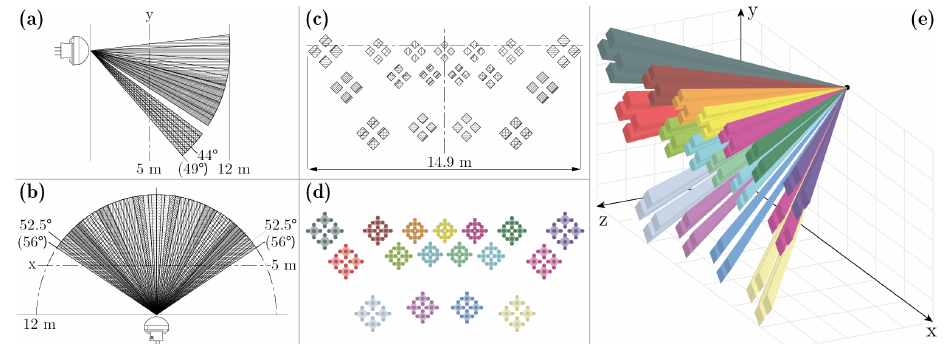
Figure 1. ( a ) side view of the Panasonic EKMC1604111 sensor’s field of view; ( b ) top view of the sensor’s field of view; ( c ) x–y cross-section of the sensor’s beam pattern; ( d ) beam pattern of the synthetic version of the EKMC1604111 sensor; ( e ) perspective view of the synthetic sensor’s beam pattern in 3D space. Subplots ( a – c ) are adapted from Panasonic’s technical data-sheet [24].